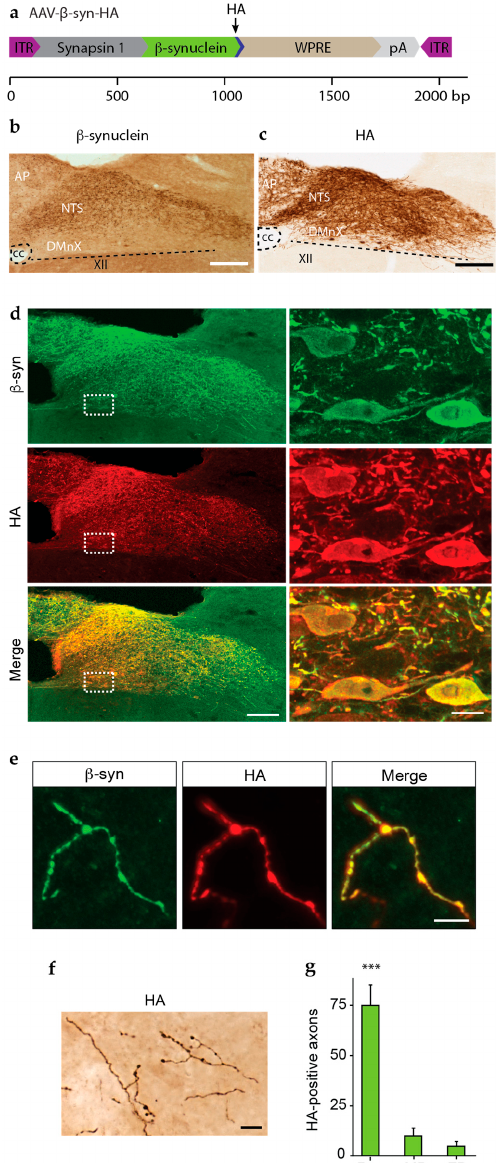
Figure 2. HA tagging allows sensitive and specific detection of β -syn protein. ( a ) Vector design of AAV- β -syn-HA. The scale bar displays the size (base pair, bp) of each genetic component. ( b – g ) Mice received an injection of AAV- β -syn-HA into the left vagus nerve and were sacrificed 6 weeks post-surgery. Brain tissue was processed for histological analyses. ( b and c ) Coronal sections of the medulla oblongata were immunostained with an antibody against β -syn ( b ) or HA ( c ). ( d ) β -syn (green) and HA (red) double immunolabeling in coronal sections of the dMO visualized by confocal microscopy. Panels on the right show transduced neuronal cell bodies in the DMnX at high magnification. Scale bars: 100 µ m (low magnification) and 10 µ m (higher magnification). ( e , f ) Coronal sections of the pons were either double-labeled with anti- β -syn (green) and anti-HA (red) and imaged with confocal microscopy ( e ) or stained with anti-HA and processed for brightfield microscopy ( f ). Scale bars: 10 µ m ( e ) and 5 µ m ( f ). ( g ) Counts of HA-positive axons in predefined coronal sections of the pons, MB, and FB. F 2,21 = 38.56, *** p < 0.0005. Abbreviations: XII: nucleus of the hypoglossal nerve; AP: area postrema; cc: central canal; DMnX: dorsal motor nucleus of the vagus nerve; ITR: inverted terminal repeat; NTS: nucleus tractus solitarius; pA: polyA; WPRE: woodchuck hepatitis virus posttranscriptional regulatory